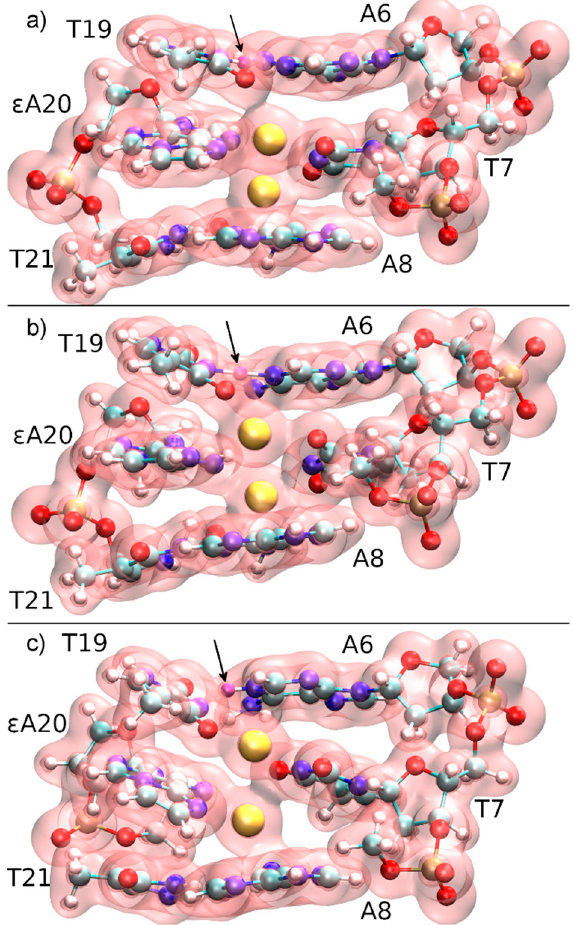
Figure 9. Total electron density of the three base pairs forming the quantum region, together with three phosphate groups neutralizing the subsystem of the constrained QM / MM molecular dynamics starting from structure 1 at D DNA = 3.7 Å. The N3H proton of T 19, which is transferred to A 6-N1, is marked with an arrow and coloured in purple. ( a ) t = 0 fs, the mercury ions (yellow) are initially located within the modified base pair, while Hg2 attracts the electron cloud from T 19, thus favouring deprotonation. ( b ) t = 140 fs, proton transfer transition state. ( c ) t = 200 fs, the proton has been transferred to A 6 and a T 19–Hg(II)– T 7 base pair is formed.